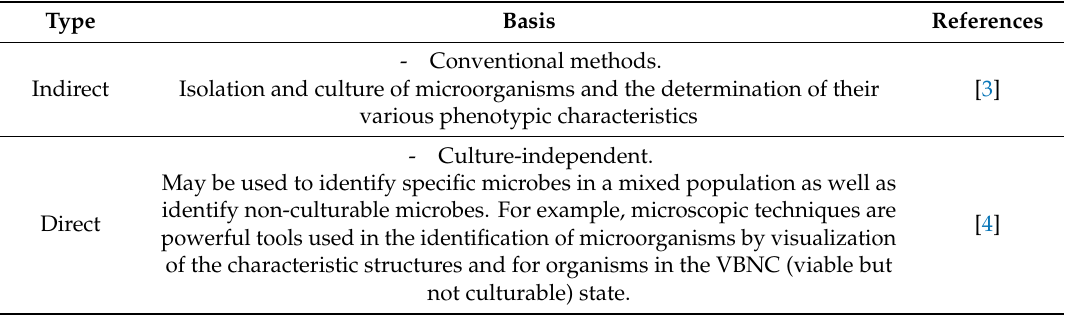
Table 1. Methods used in the area of microorganism identification.